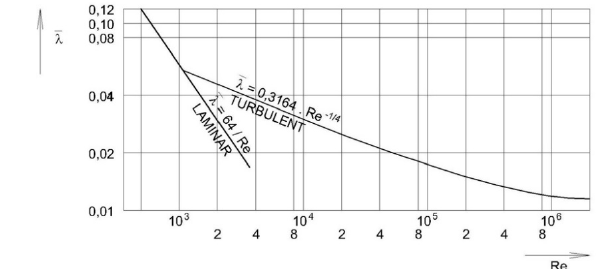
Figure 4: Graphic representation of a coeflcient of friction as a function of the cavity height ¯ λ = f ( Re ) .